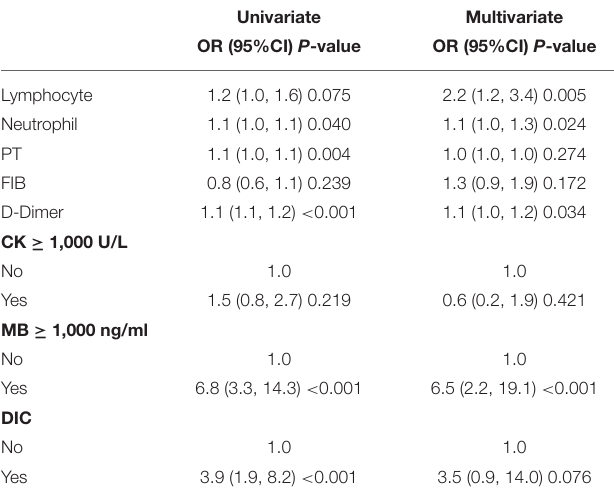
TABLE 2 | Risk factors for EHS complicated with AKI. Univariate Multivariate